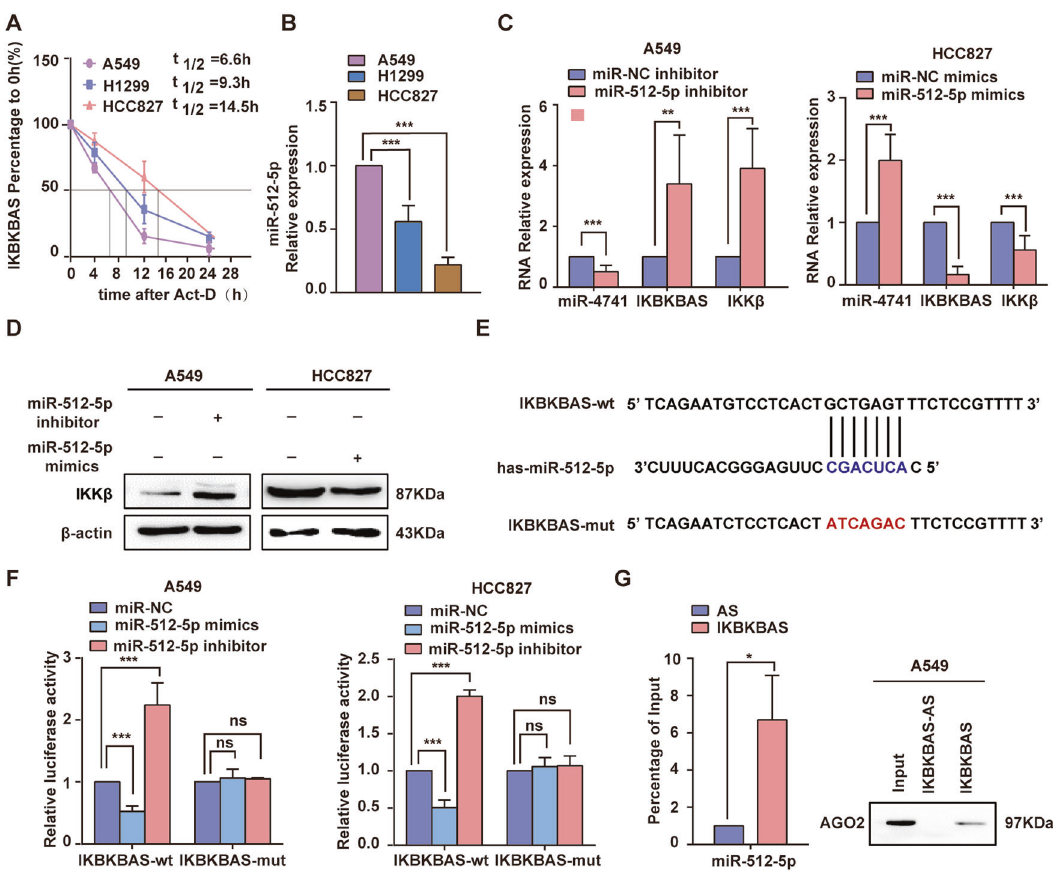
inhibitor or mimics on expression of miR-4741, IKBKBAS, or IKK β mRNA in A549 (left) and HCC827 (right) cells was assayed by qRT-PCR. D The effect of miR-4741 inhibitor or mimics on expression of IKK β in A549 and HCC827 cells were assayed by western blot. E Schematic representation of the predicted binding sites for miR-512-5p on IKBKBAS and IKK β 3 ′ UTR, and the site mutagenesis design for the luciferase reporter assay. F Luciferase reporter assay con fi rmed the interaction between miR-512-5p and IKBKBAS in A549 and HCC827 cells. A549 and HCC827 cells were co-transfected with miR-512-5p mimic or miR-512-5p inhibitor and pMIR-IKBKBAS-wt/mut plasmids.miR-NC mimics or miR- NC inhibitor were also transfected as control. Transfected cells were harvested after 48 h and subjected to luciferase activity assay. G The association among IKBKBAS, miR-512-5p, and AGO2 was ascertained by RNA pull-down assay using A549 cell lysates. Left: Detection of miR-512-5p by qRT-PCR in the sample pulled down using biotinylated IKBKBAS and IKBKBAS-AS (negative control) probes; right: Detection of AGO2 by western blot in the sample pulled down using biotinylated IKBKBAS and IKBKBAS-AS (negative control) probes. Data show mean ± S. E.M., n ≥ 3, * P < 0.05, ** P < 0.01, *** P <